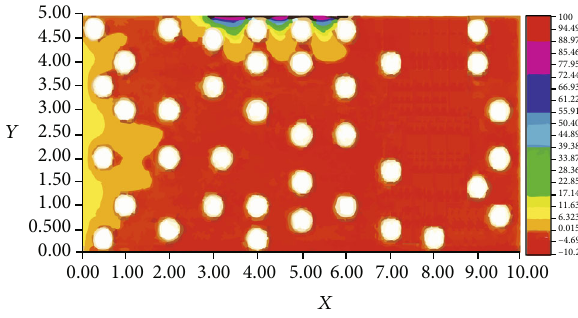
Figure 16: Concentration, D = 0 : 5 , C